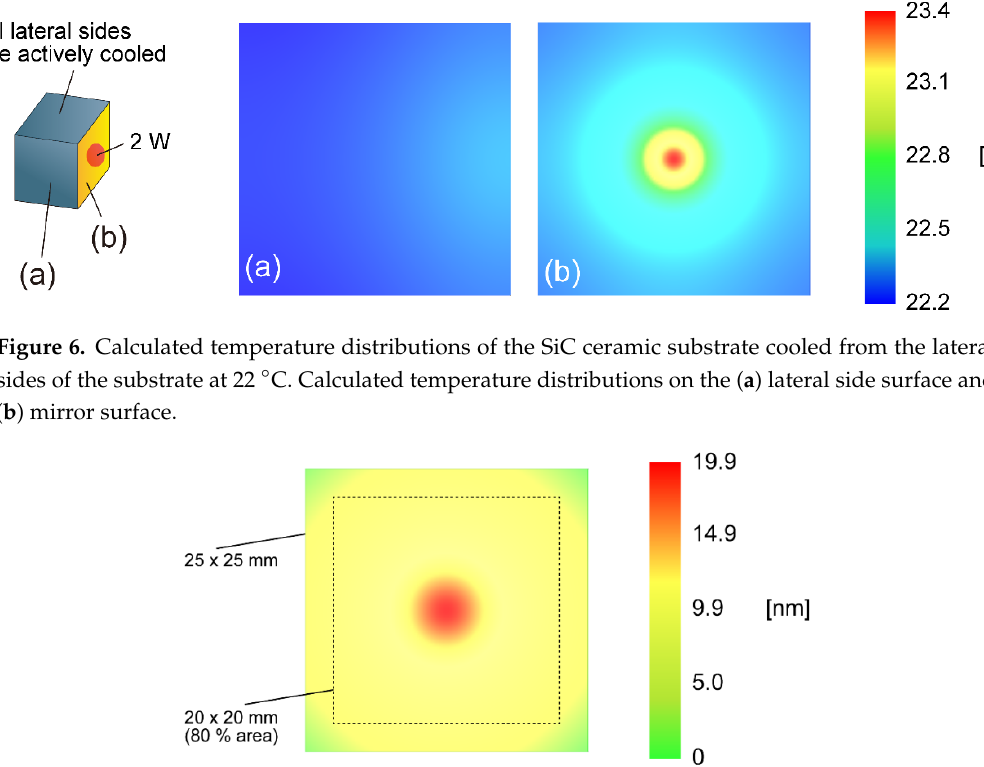
Figure 7. Calculated deformation of the mirror surface in the actively cooled SiC ceramic substrate.